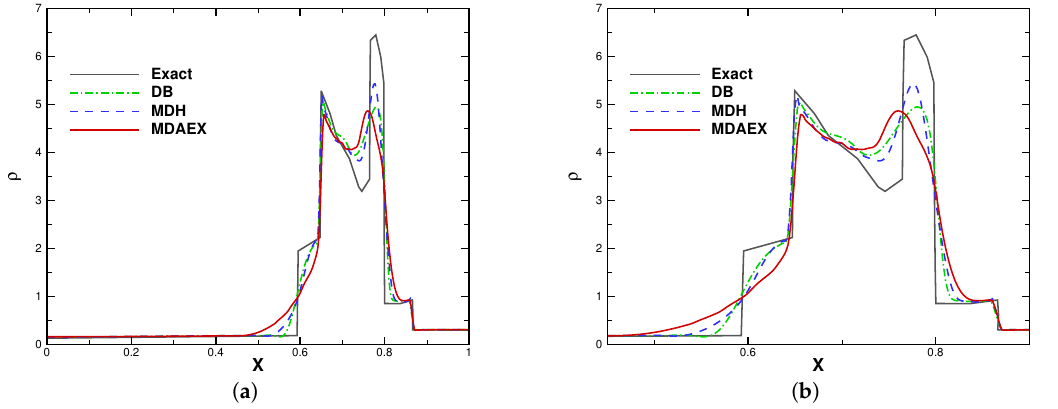
Figure 13. Density solution for the blast wave problem with 300 elements at t = 0.038, P 1. ( a ) Overview; ( b ) zoomed in results.